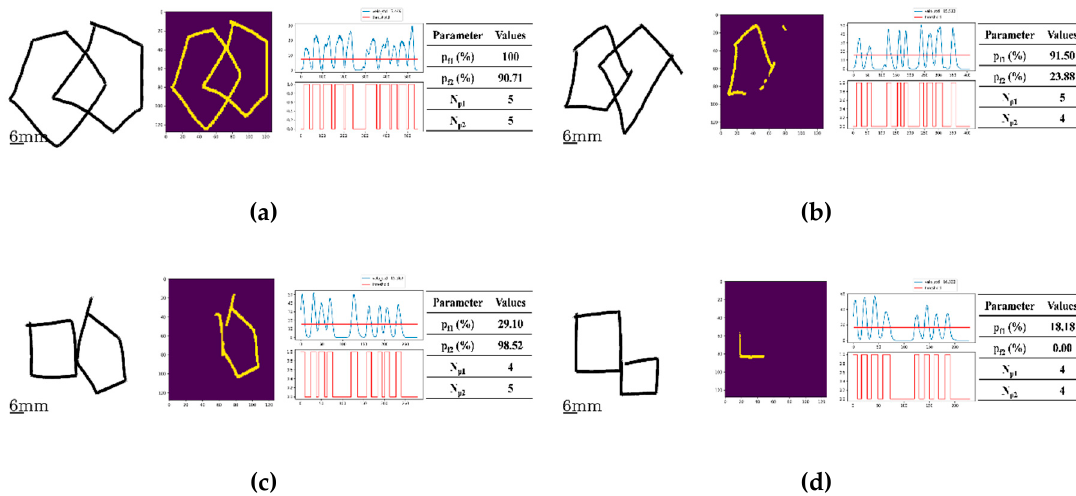
Figure 4. Four examples of original drawings (left) along with their segmented images (middle left) produced by the pre-trained model, Deep5, their corresponding velocity graphs (middle right), and the corresponding parameter values (right). The number of angles was evaluated from the number of peaks detected in the velocity graph: ( a ) The image is composed of two interlocking figures, both being pentagons where the number of angles for both figures was evaluated to be 5 ( p f 1 and p f 2 were 100.00% and 90.71%, respectively, and both greater than 75%). ( b ) The image of two interlocking figures, but with only one being a pentagon (the left-side figure). The number of angles of the left-side figure was evaluated to be 5, as p f 1 was 91.5% and it was greater than 75%. For the right-side figure, the number of angles was given as 4, as the percentage p f 2 of 23.88% was less than 75% and the number of peaks detected in the velocity graph is 4. ( c ) The image of the right portion is a pentagon with the number of angles evaluated as 5 as p f 2 was 98.52% and it was greater than 75%. The image of the left portion was evaluated as a 4, as p f 1 was 29.10% and it was less than 75% and the number of peaks detected in the velocity graph is 4. ( d ) The image, composite of two figures, none of them being a pentagon. This is because the number of angles for each of the right and left-hand portions was evaluated to be a 4, since p f 1 and p f 2 were 18.18% and 0.00%, respectively, both being less than 75%. The numbers of angles in both the right and left portions were evaluated to be 4, matching the number of peaks detected in the velocity graphs for both.